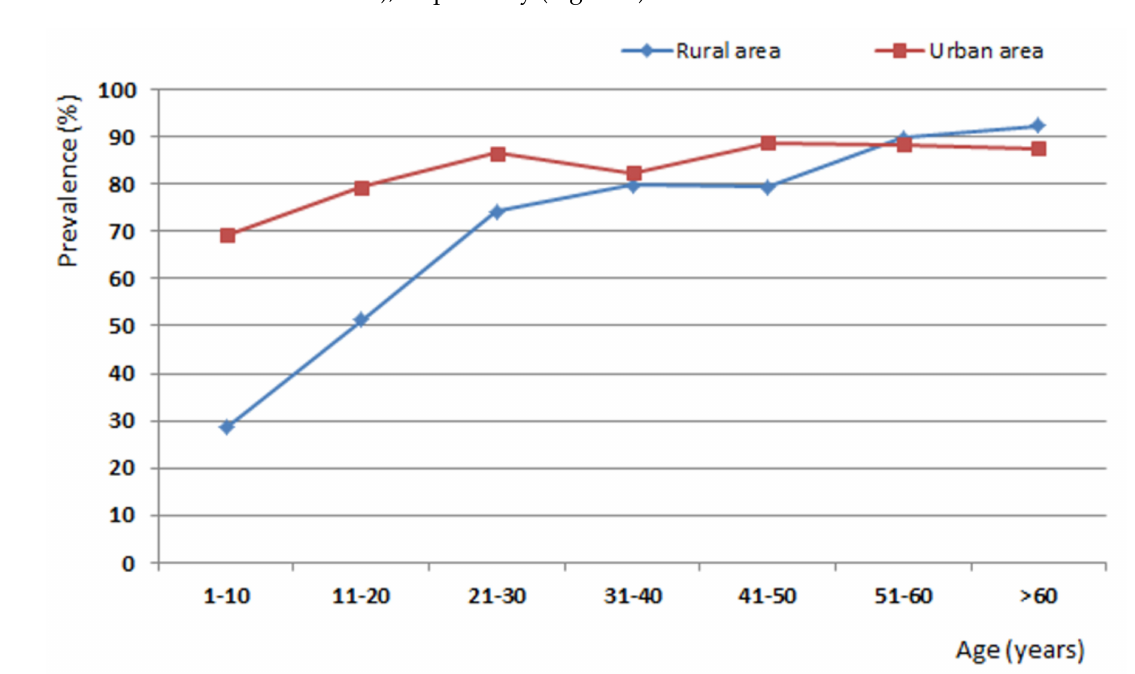
Figure 2. Anti- T. gondii IgG prevalence curve by age group in individuals living in urban and rural areas in the municipality of Ponta de Pedras, Par á , Brazil, from August 2015 to April